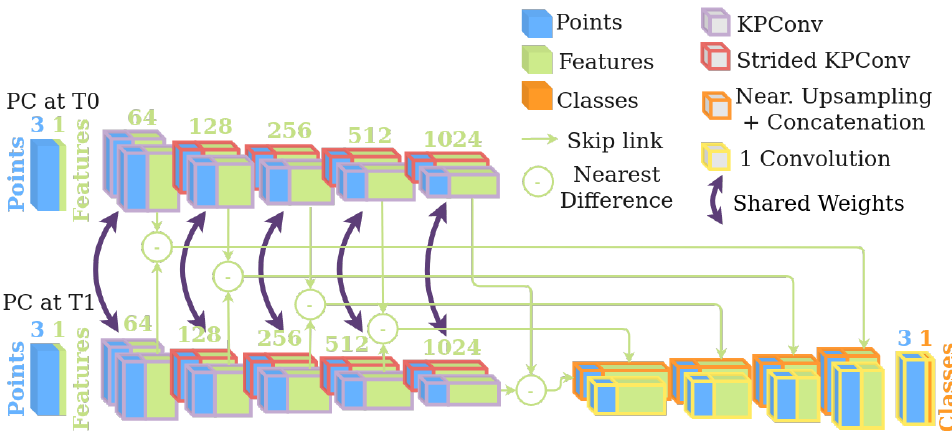
Figure 1. Our Siamese KPConv network architecture.